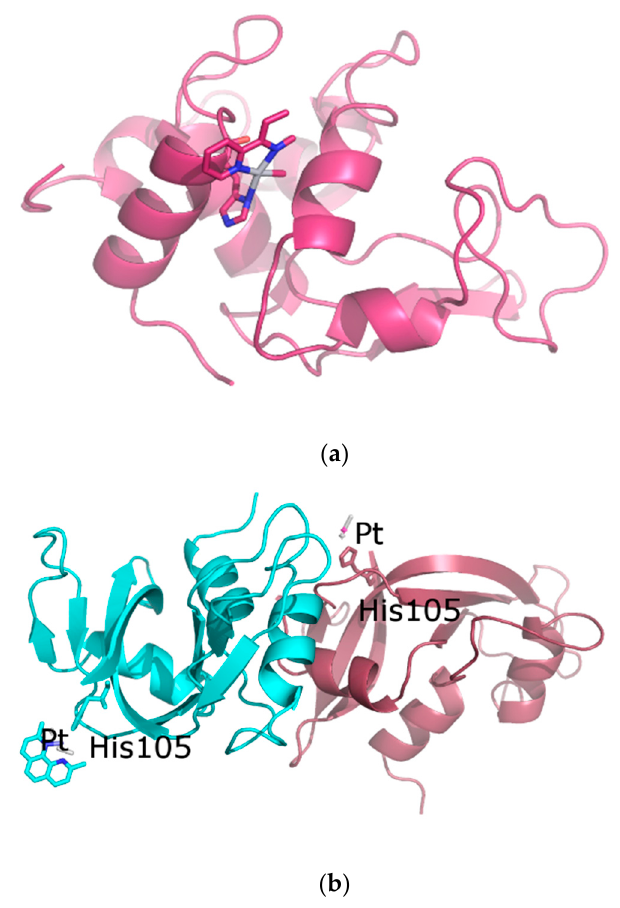
Figure 3. Overall structures of the HEWL ( a ) and the RNase A adducts ( b ). The Pt center is bound to the side chain of His15 in the HEWL adduct, and to the side chains of His105 of both RNase A molecules in the asymmetric unit of the crystal of the RNase A adduct.